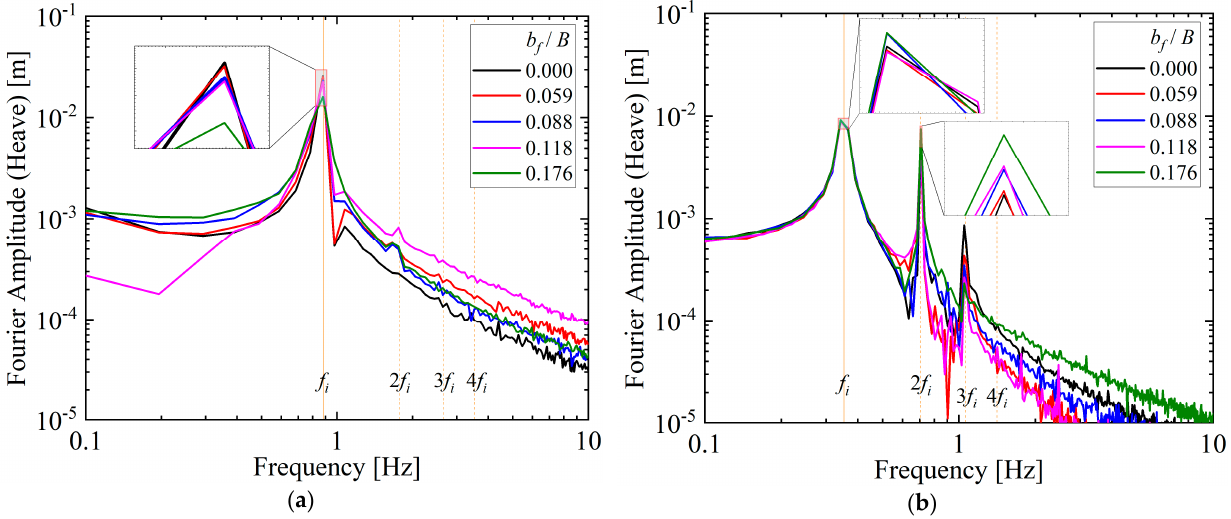
Figure 10. Fourier amplitude of the heave: ( a ) f i = 0.88 Hz; ( b ) f i = 0.35 Hz.